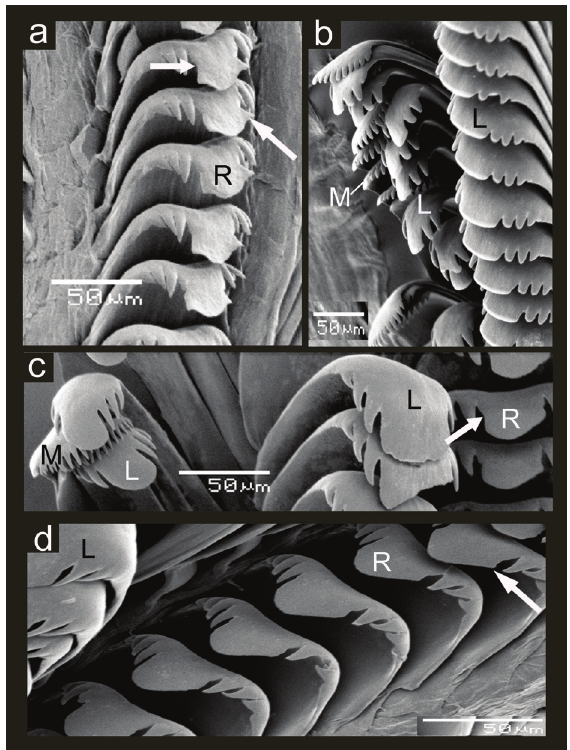
Figure 6 - Radular variability of Sinotaia cf quadrata . a. Rachidian teeth (R) of a female with basal constriction and distal expansion (arrows); b . Female’s lateral (L) and marginal (M) teeth; c. Rachidian teeth of a male individual with constriction (arrow), lateral (L) and marginal teeth (M); d. Rachidian teeth of a male with basal constriction and small lateral expansions (white